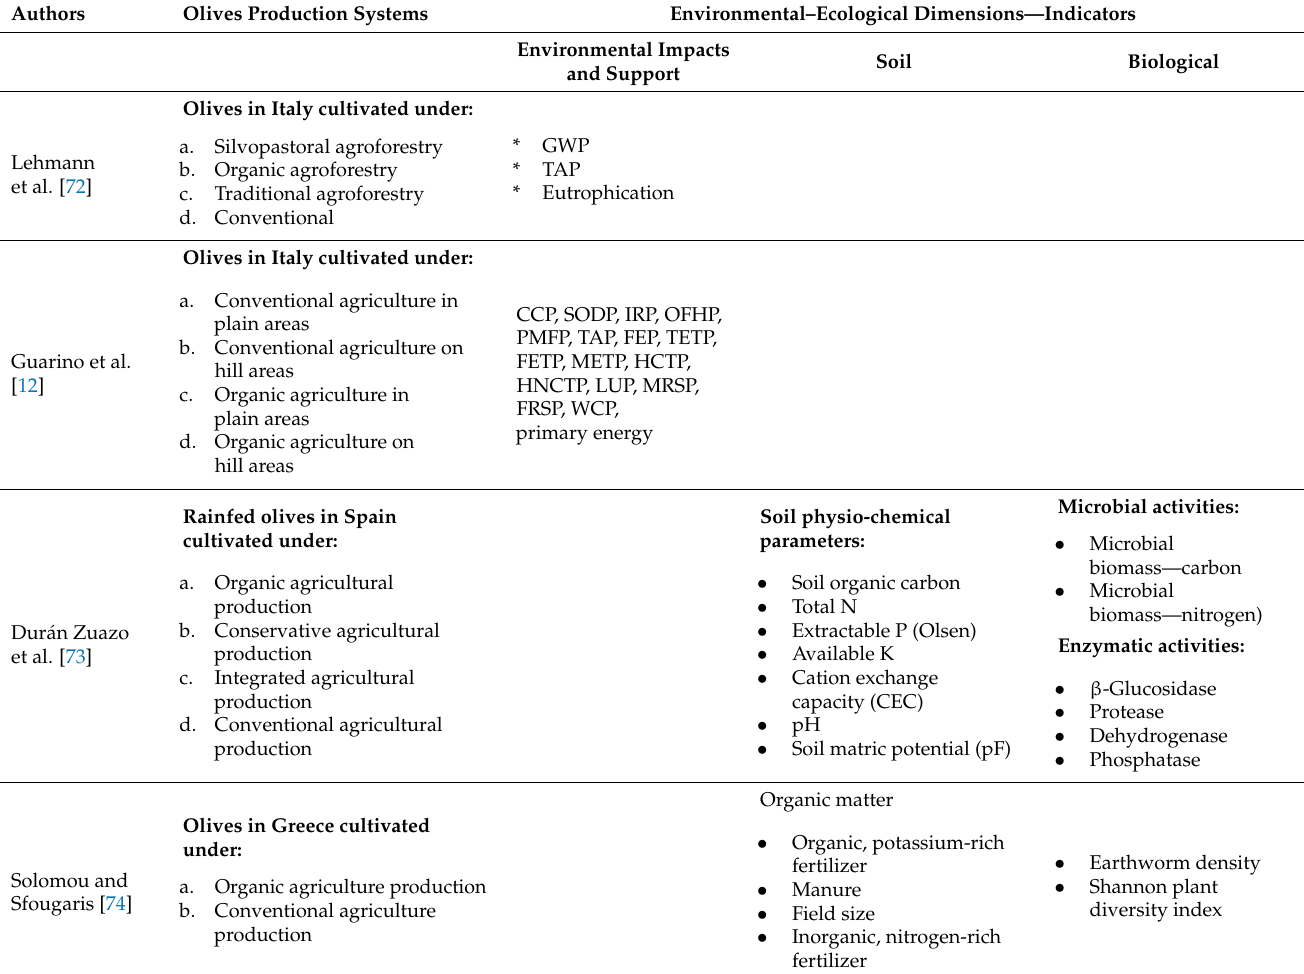
Table 4. Environmental and biophysical indicators of different schemes of olive systems production investigated by different